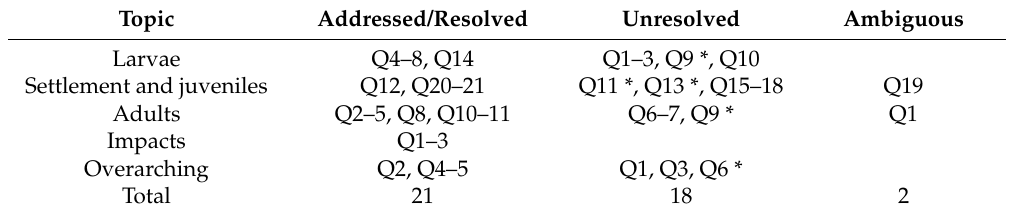
Table 1. Research progress against each of the specific questions posed by Moran [21]. Numbers reflect the original numbering of questions, as referred to in heading throughout Section 2. “*”